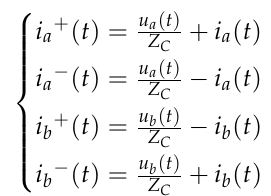
where i a + ( t ) and i b + ( t ) denote the positive traveling wave current on the a-side and b-side of the DC line, respectively, i a − ( t ) and i b − ( t ) denote the reverse traveling current on the a-side and b-side of the DC line, respectively, i a ( t ) and i b ( t ) denote the current on the a-side and b-side of the DC line, respectively, u a and u b represent the voltage on the a-side and b-side of the DC line, respectively, and Z c is the wave impedance of the DC line.